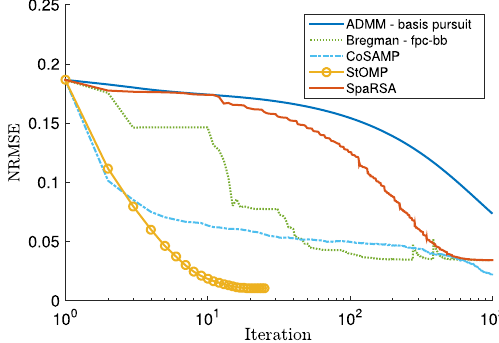
Fig. 8 Plots showing the decay of the normalized L 2 error (NRMSE) with iterations for different sparse reconstruction algorithms, as indicated. Results are reported for the function f plotted in Fig. 4 ( top row ) for R ¼ 10 and w ¼